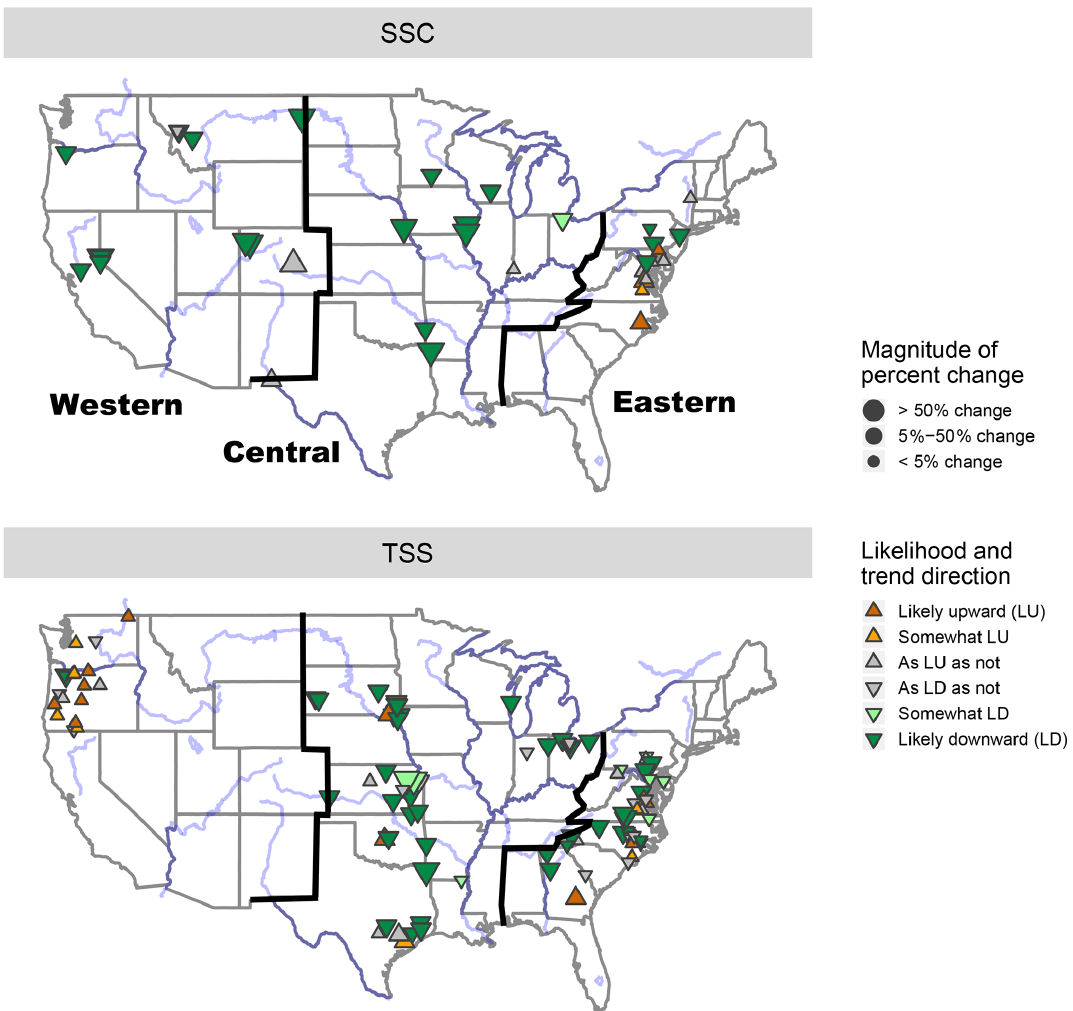
Figure 1. Sediment trends from 1992 to 2012, showing trend direction, likelihood category and magnitude for suspended-sediment con- centration (SSC) and total suspended-solid concentration (TSS). Base map generated using the ggmap package of the R statistical software program. (Kahle and Wickham,